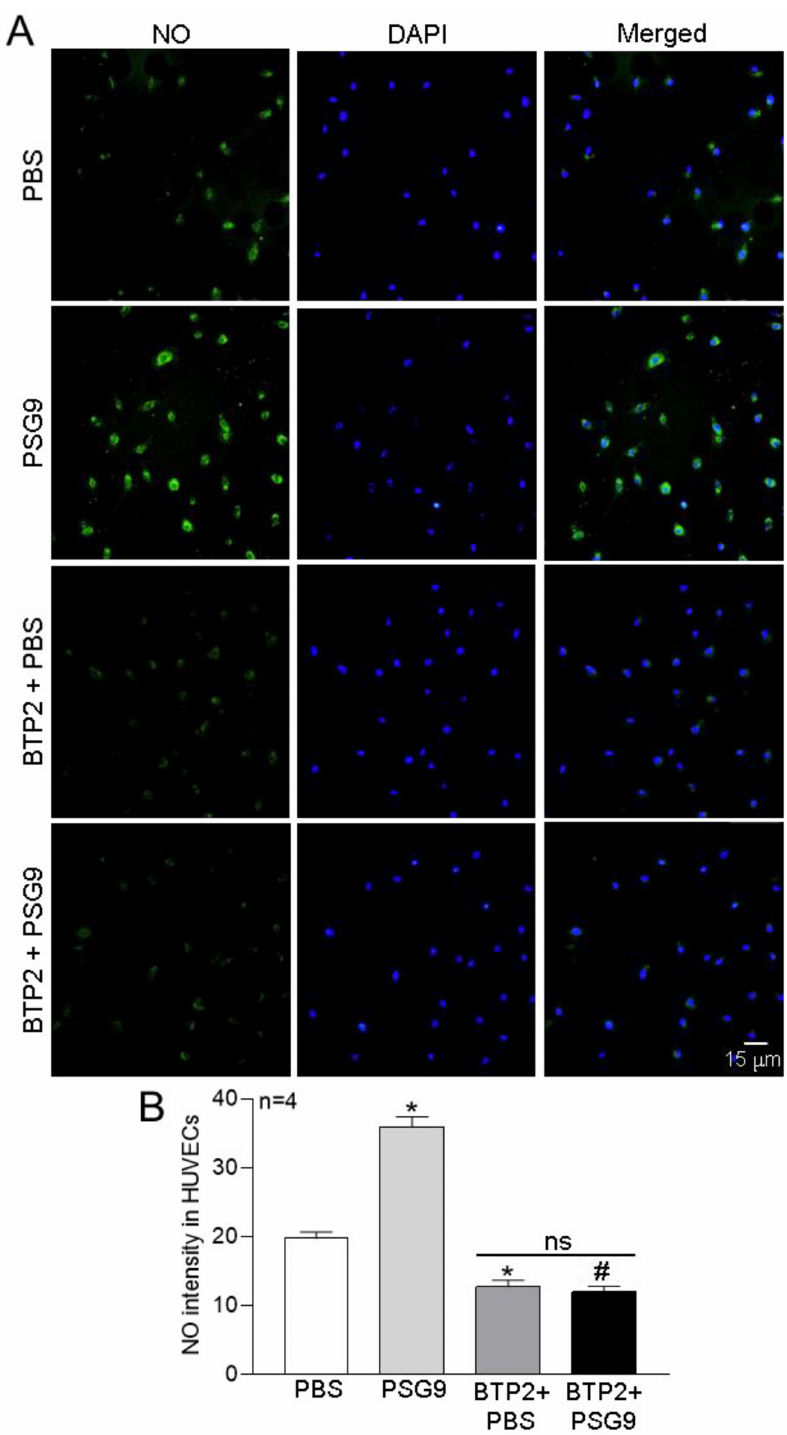
Figure 5. Effect of PSG9 on nitric oxide (NO) production in human umbilical vein endothelial cells (HUVECs). ( A , B ) Representative fluorescence images ( A ) and summary data ( B ) showing NO lev- els (green fluorescence) in HUVECs treated with PBS, BTP2 (5 µ M) + PBS, 0.1 µ g/mL PSG9, and 0.1 µ g/mL PSG9 + BTP2 (5 µ M). The nucleus is indicated by blue fluorescence (4 (cid:48) ,6-diamidino- 2-phenylindole; DAPI). Values are shown as the mean ± SEM of fluorescence arbitrary units ( n = 4 in each group). * p < 0.05 compared with PBS, # p < 0.05 compared with PSG9; ns, no significant